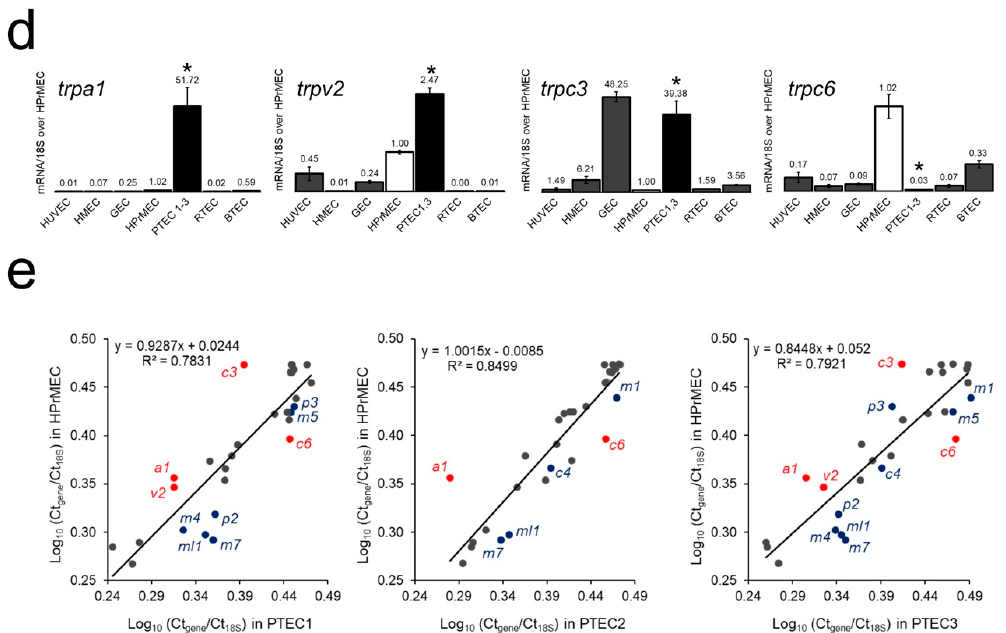
Figure 1. Identification of the trp expression signature in PTEC. ( a ) Heatmap showing the relative mRNA expression of the trp genes in TECs of different origins. TEC expression normalized based on normal endothelial counterparts: PTEC1-3 expression is normalized against HPrMEC expression, while BTEC and RTEC expression is normalized against HMEC and GEC expression, respectively. ( b ) Differential analysis of PTEC1-3 and HPrMEC highlighted six genes (i.e., trpa1 , trpc1 , trpc4 , trpm1 , trpm7 , and trpml1 ) that are differentially deregulated (adjusted p -value < 0.1, red line), while the other genes did not show significant deregulation. ( c ) Differential analysis identified six genes that are differentially deregulated (panels a , b ), and twelve genes displayed at least 2-fold change in their expression in at least two patient lines (panel e ). Among these, four channels ( trpa1 , trpv2 , trpc3 and trpc6 ) were selected as ‘ prostate-associated ’. ( d ) Real-time qPCR analysis of mRNA expression shows that trpa1 , trpv2 , trpc3 and trpc6 are deregulated in PTEC1-3 relative to those in normal HPrMEC, and the deregulation is observed only in the prostatic tissue but not in the other normal ECs or TECs tested. Values are expressed as the mean ΔΔ CT values ± SEM of at least three independent experiments. *: p -value < 0.05. ( e ) Scatter plots showing the expression of trp channels in PTEC1 (left panel), PTEC2 (central panel) and PTEC3 (right panel) relative to that in HPrMEC, as determined by real-time qPCR. Gray dots indicate genes with less than 2-fold change in PTEC relative to those in HPrMEC. Blue dots indicate genes with more than 2-fold change in at least one PTEC line relative to those in HPrMEC. Red dots showing the four ‘ prostate-associated ’ genes (i.e., trpa1 , trpv2 , trpc3 , and trpc6 ), with more than 2-fold change in at least 2 PTEC lines out of three. Correlation values for trp channels are expressed as Log (C_(T,gene x)/C_(T,18s)) in primary PTEC ( x -axis) and normal HPrMECs ( y -axis).